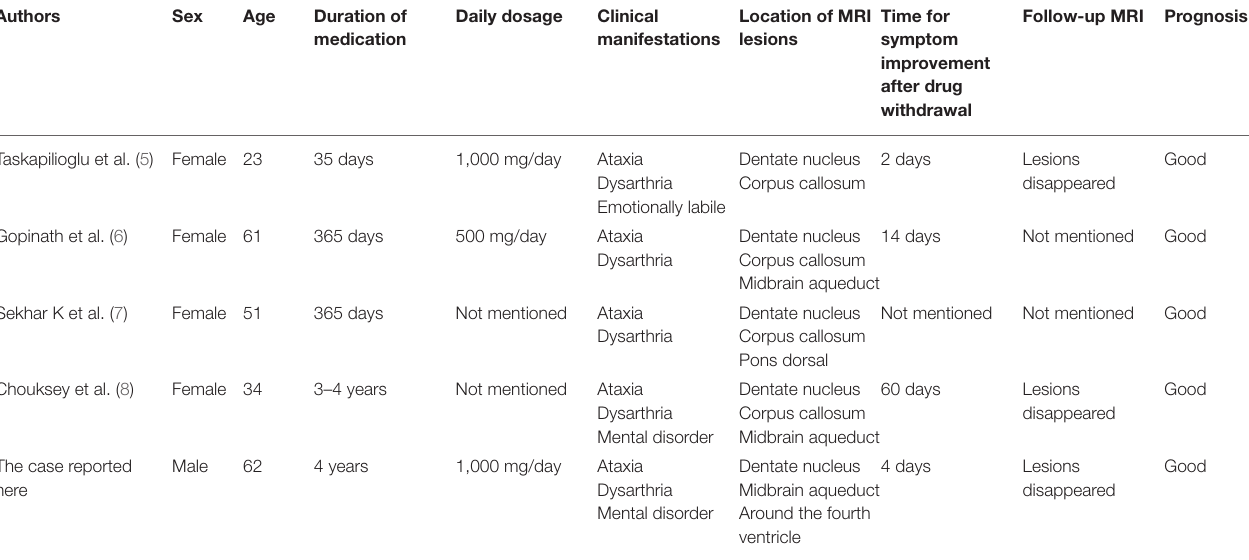
TABLE 1 | Literature review on ornidazole-induced encephalopathy (OIE). Authors